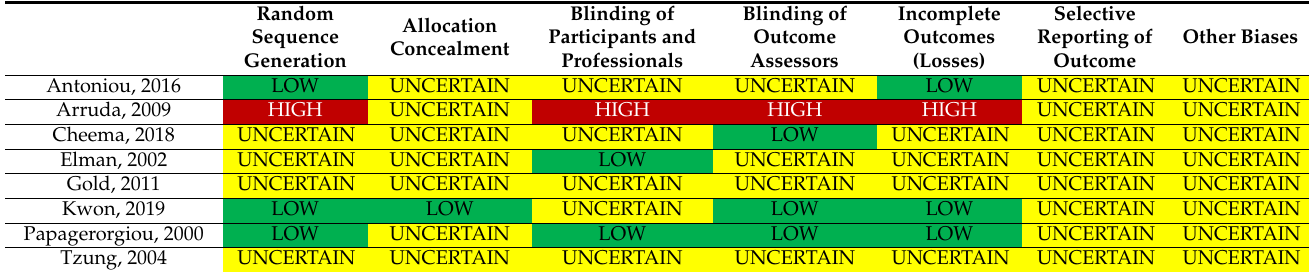
Table 4. Risk of individual biases of the eight studies selected for systematic review for each domain of risk assessment of bias in randomized clinical trials by the Cochrane collaboration